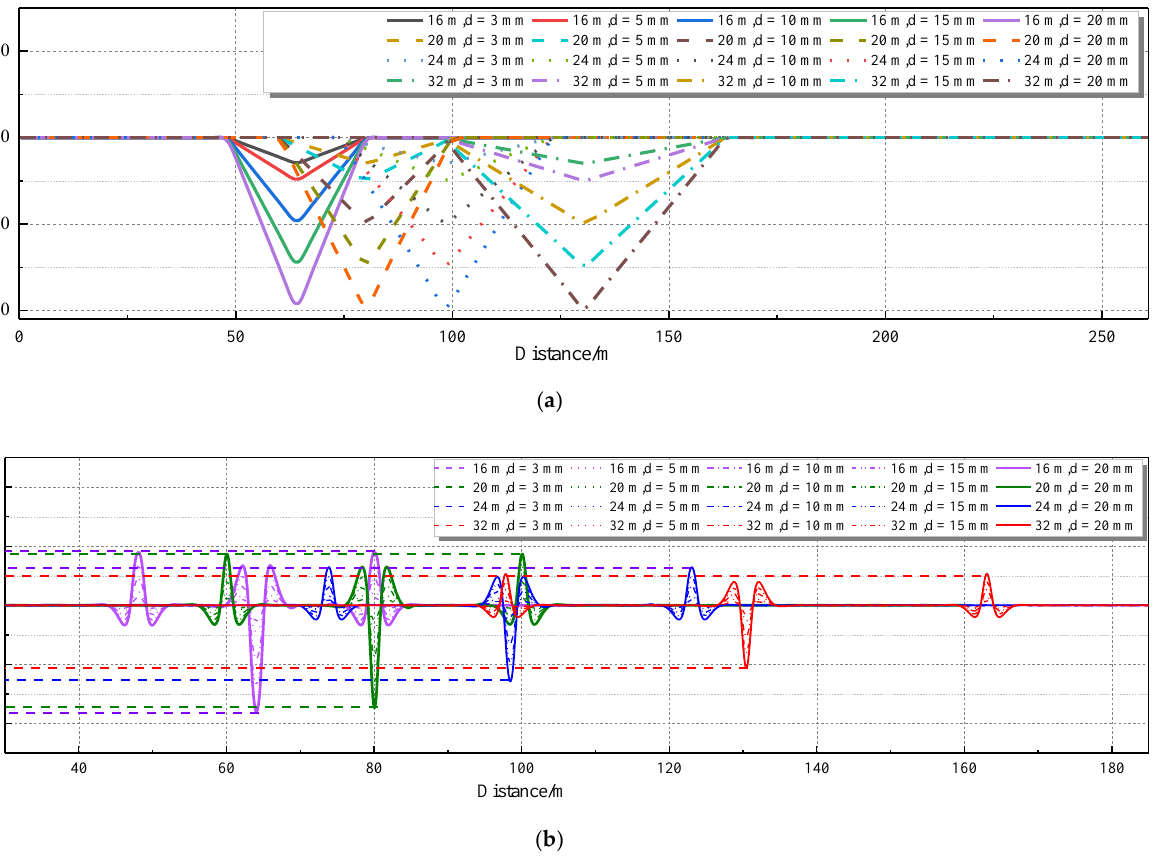
Figure 12. The influence of girder span length. ( a ) Rail deformation of simply supported bridges with different span lengths. ( b ) Fastener stiffness of simply supported bridges with different span lengths.